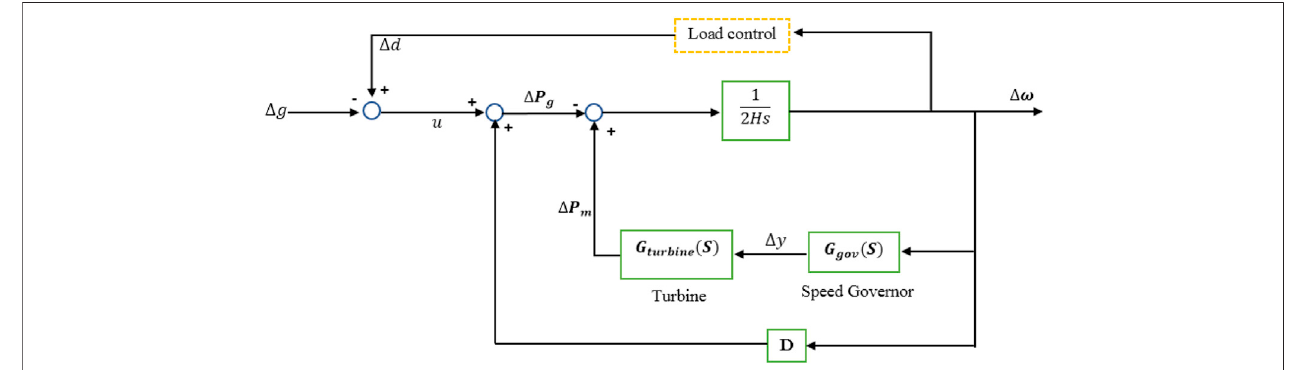
FIGURE 2 | Dynamic representation of the model